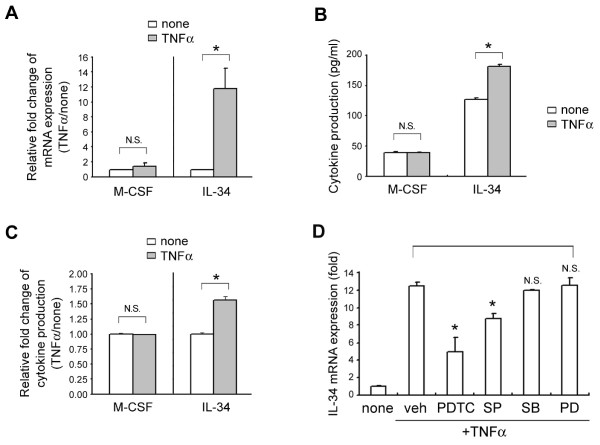
Effect of tumor necrosis factor alpha (TNFα) on the expression of interleukin-34 (IL-34) and macrophage colony-stimulating factor (M-CSF) in rheumatoid arthritis (RA) fibroblast-like synovial cells (FLS). (A) RA FLS were treated with or without 10 ng/ml TNFα for 24 hours, and M-CSF and IL-34 mRNA levels were determined in cell lysates by quantitative reverse transcriptase-PCR (qRT-PCR). The relative expression of M-CSF (left) and IL-34 (right) mRNA after TNFα treatment is presented as fold-change in gene expression compared to untreated controls (none). Bars indicate the mean and SD of M-CSF or IL-34 mRNA expression relative to that of glyceraldehyde 3-phosphate dehydrogenase (GAPDH) (*P< 0.05, N.S., not significant, compared to none). (B) Cells were cultured as described in panel A, and the concentration of M-CSF (left) or IL-34 (right) in the medium was measured by an enzyme-linked immunosorbent assay (ELISA). (C) TNFα-mediated induction of M-CSF (left) or IL-34 (right) protein production was converted into fold change relative to that of control (none). Bars indicate the mean and SD of M-CSF or IL-34 protein relative to that of control (*P < 0.05, N.S., not significant, compared to none). (D) Nuclear factor kappa B (NF-κB) and c-Jun N-terminal kinase (JNK) dependent IL-34 mRNA expression upon TNFα stimulation in RA FLS. RA FLS were pretreated with the vehicle (dimethyl sulfoxide, 10 μM), NF-κB inhibitor, pyrrolidine dithiocarbamate(10 μM), the JNK inhibitor, SP600125 (10 μM), the p38 inhibitor, SB203580 (10 μM), or the extracellular signal-regulated protein kinase (ERK) inhibitor, PD98059 (10 μM), for 30 minutes and then treated with 10 ng/ml TNFα for 24 hours. Untreated RA FLS were used as a control (none). M-CSF and IL-34 mRNA levels were determined in cell lysates by qRT-PCR. The relative expression of IL-34 mRNA is presented as fold change in gene expression compared to untreated vehicle controls (*P < 0.05, N.S., not significant, compared to veh). none, no treatment; veh, vehicle; SP, SP600125; SB, SB203580; PD, PD98059.